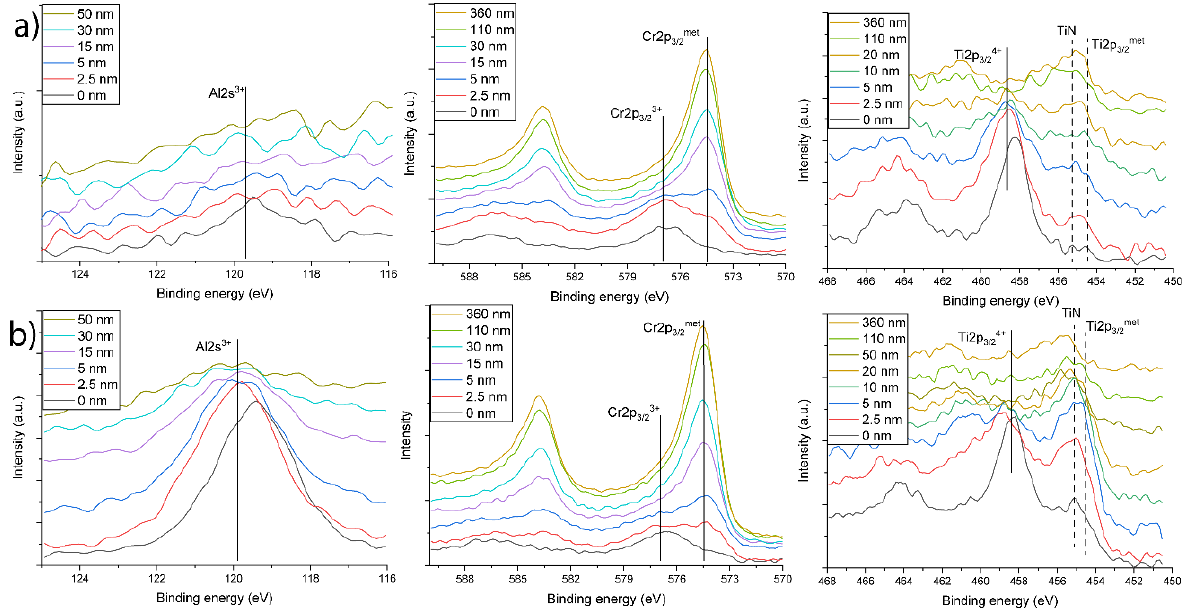
Figure 5. Comparison of depth profile of Al2s, Cr2p and Ti2p spectra for ( a ) virgin and ( b ) reused powder.